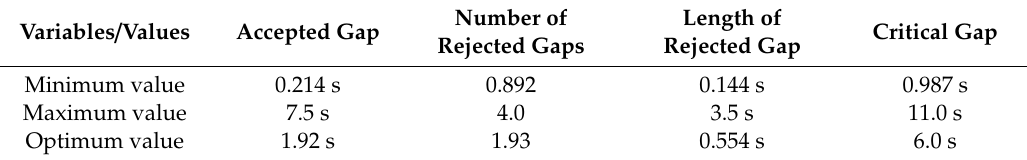
Figure 8. Results from the fuzzy system. Table 3. Output results from the proposed fuzzy system.